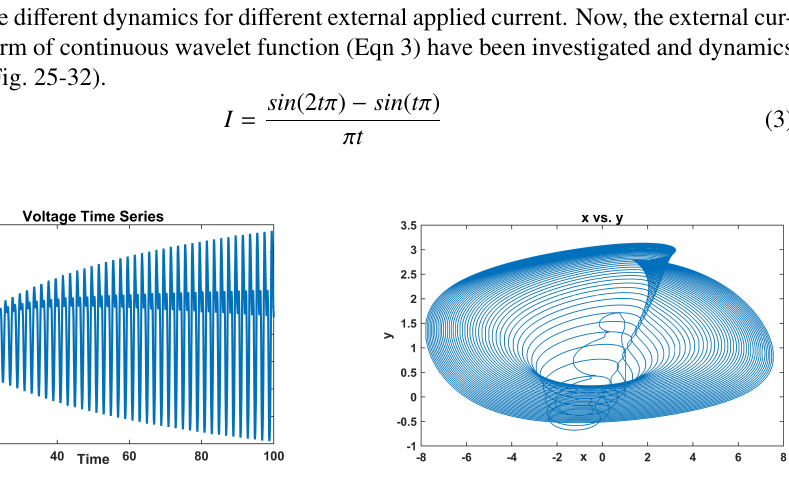
Figure 26. Recovery variable (right) with pa- rameter values a = 0.7, b = 0.8, c = 3